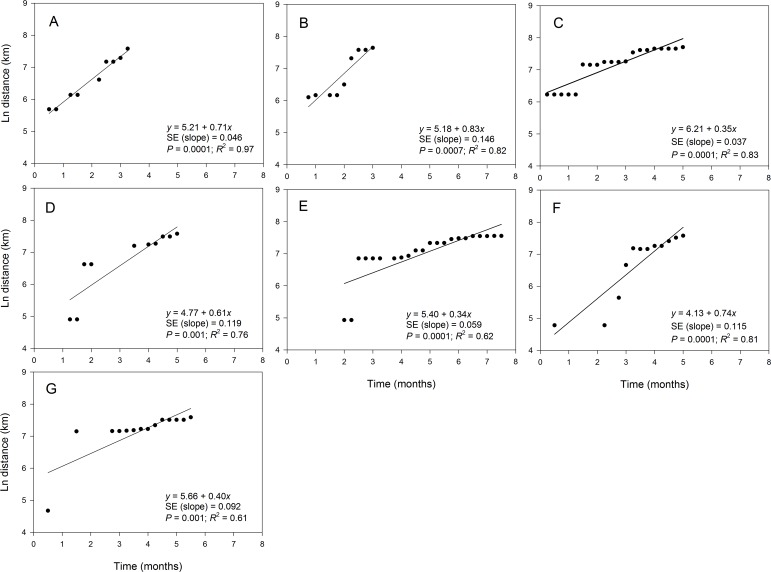
Relationship between the position of epidemic wave-front and time for epidemics examined in specific years.Regression of the position of the epidemicwave-front (log-scale) on time for representative epidemic years. (A) 2008, (B) 2009, (C) 2010, (D) 2011, (E) 2012, (F) 2013, and (G) 2014. Symbols are means of the position of the epidemic wave-front across 10-transect directions.